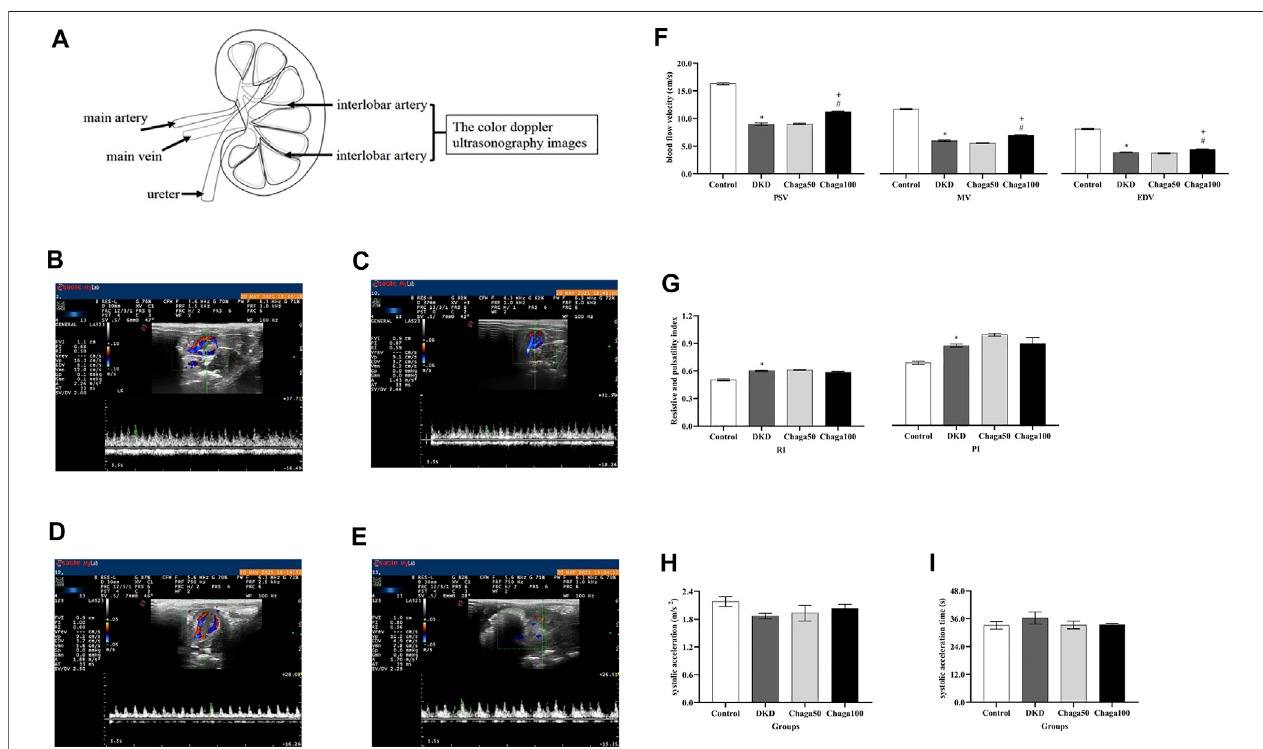
FIGURE4| AnatomicallocationoftheLRILA andtheeffects ofchaga extractsontheLRILAwithcolorDopplerultrasonography. (A) Theanatomicallocationofthe renalinterlobarartery. (B – E) ColorDopplerultrasonographyimagesofLRILAofratsineachgroup. (B) Normalcontrolgroup. (C) DKDmodelgroup. (D) Chaga50group. (E) Chaga100 group. (F – I) Color Doppler ultrasonography parameters of LRILA of rats in each group. (F) peak systolic velocity (PSV), mean velocity (MV) and end- diastolicvelocity(EDV)oftheLRILAindifferentgroups. (G) resistiveindex(RI)andpulsatilityindex(PI)oftheLRILAindifferentgroups. (H) systolicacceleration(SAC) of the LRILA in different groups. (I) systolic acceleration time (SAT) of the LRILA in different groups. Data were presented as mean ± SE. DKD, diabetic kidney disease; Chaga50,treatmentwith50 mg/kgofchagagroup;Chaga100,treatmentwith100 mg/kgofchagagroup;LRILA,leftrenalinterlobarartery.* p < 0.05vs.Normalcontrol group, # p < 0.05 vs. DKD model group. + p < 0.05 vs. Chaga50